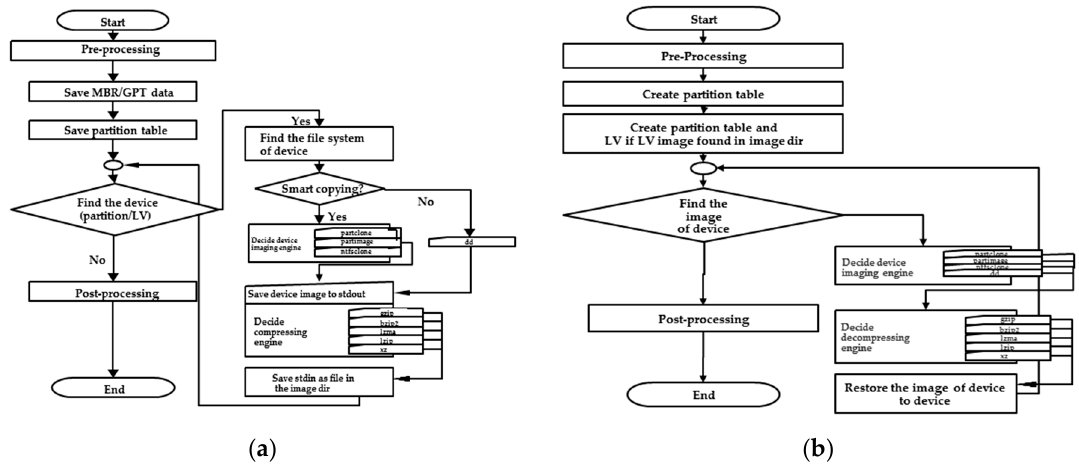
Figure 2. Flowchart for ( a ) saving and ( b ) restoring an image.